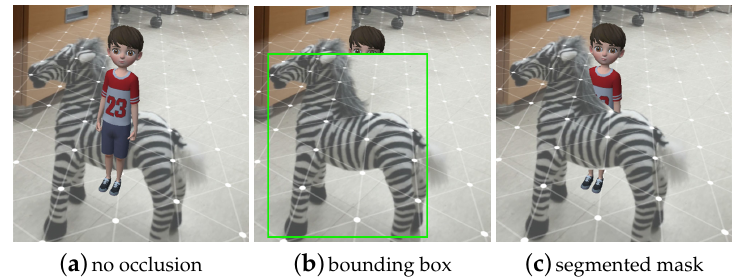
Figure 9. Different types of strategies for applying